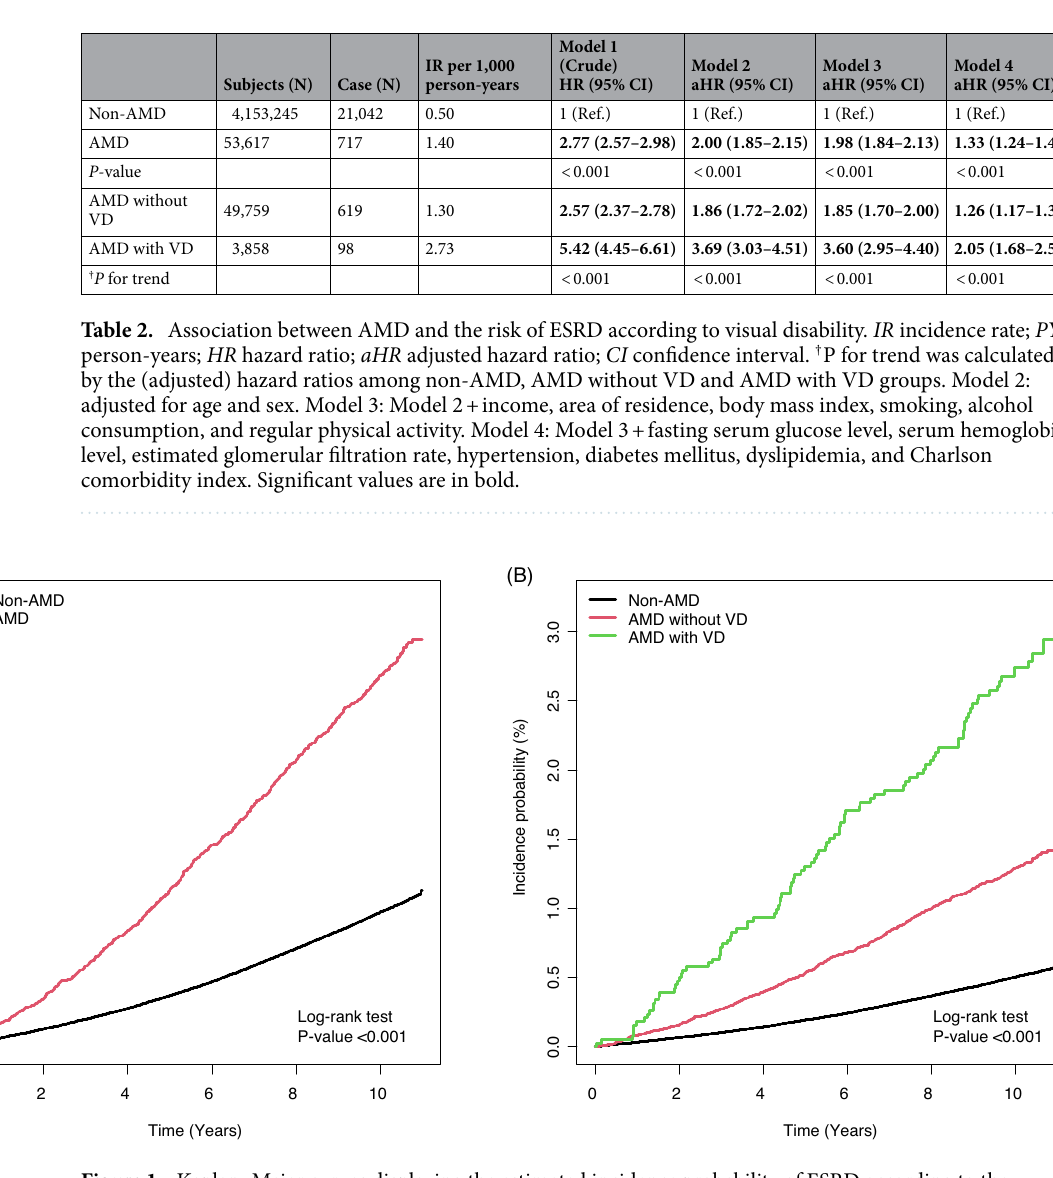
Figure 1. Kaplan–Meier curves displaying the estimated incidence probability of ESRD according to the presence of AMD, and VD. Kaplan–Meier analysis estimated an increased risk of ESRD in people with AMD ( A ); In addition, compared to non-AMD group, an increased risk of ESRD among the AMD without VD group, and an even higher risk of ESRD among the AMD and VD group were observed ( B ). AMD, age-related macular degeneration; VD, visual